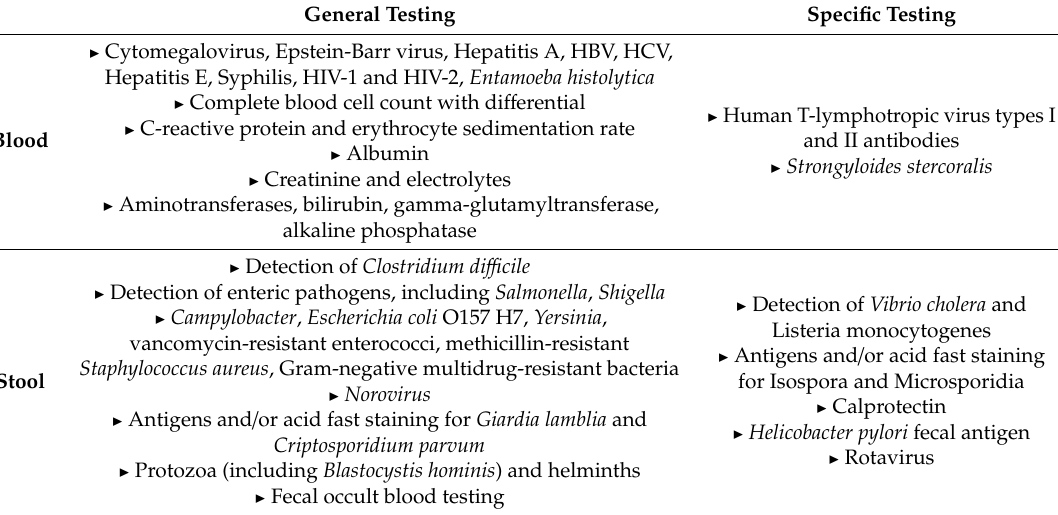
Table 5. Blood and stool testing to check donors for any potentially transmittable disease (Screening